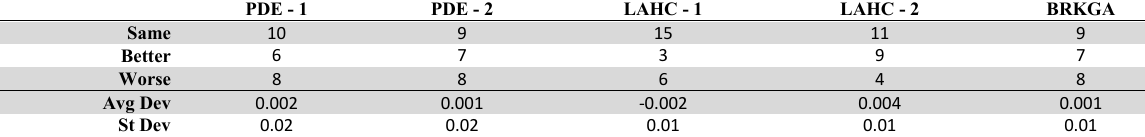
Summarised Results for Problem Set 2 ( t i / p i < 0.25)